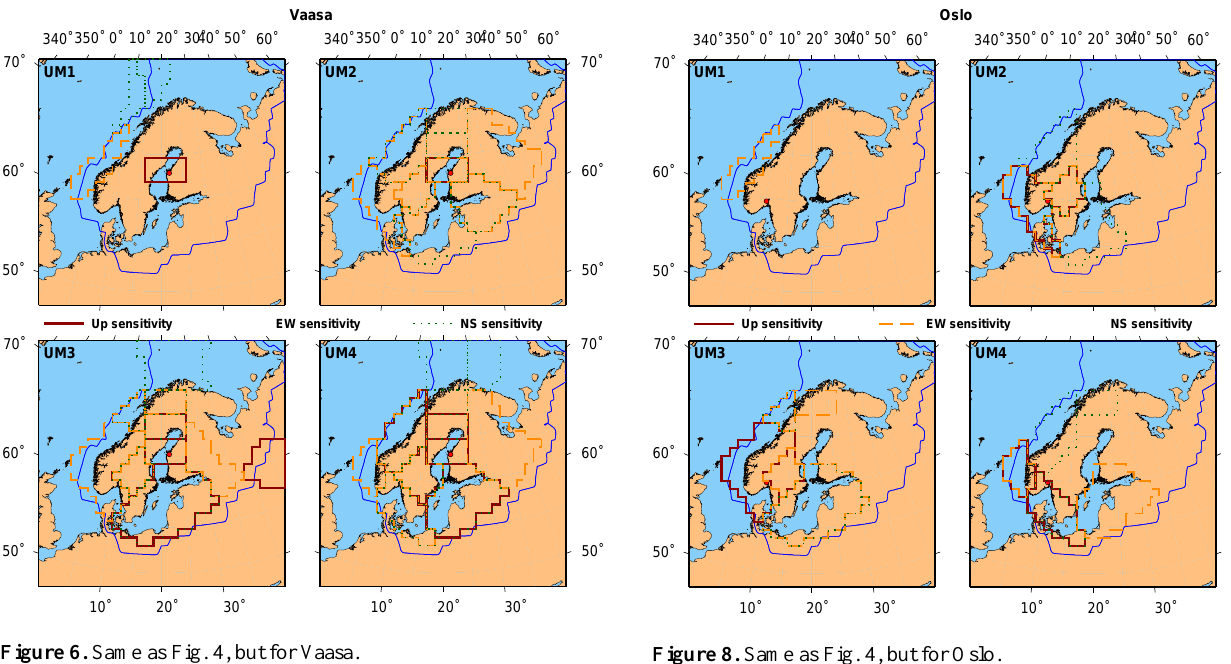
Fig.6. SameasFig.4,butforVaasa. Figure 6. Same as Fig. 4, but for Vaasa.